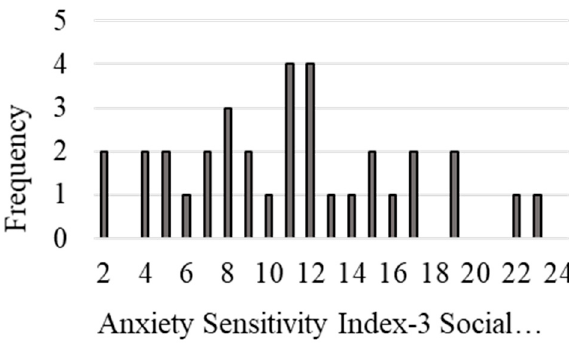
Figure 1. Questionnaire response distributions. Table 2. Linear Multiple Regression